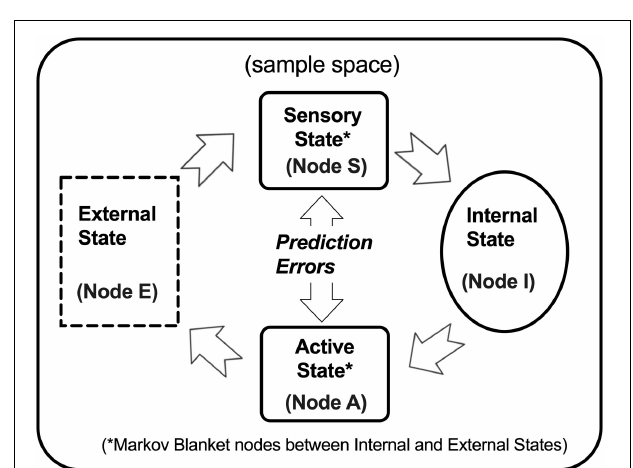
FIGURE 1 | Bayesian active inference framework. Biological organisms are Bayesian Engines, equipped with nodes of Sensory State and Active State (Node S and A, solid round-corner rectangles) and of Internal State (Node I, solid oval), to observe events from the node of External State (Node E, dashed rectangle) in a sample space (bounded by the outer boundary). The causal relations among these nodes follow Free-Energy Principle, described in Box 1